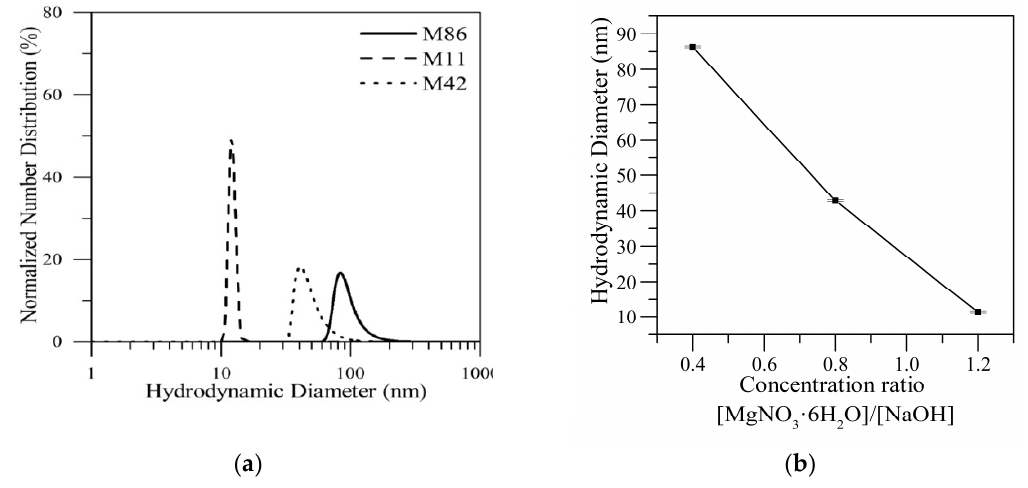
Figure 4. ( a ) Normalized number distribution of three different sizes of MgO nanoparticles 11 (M11), 42 (M42), and 86 nm (M86) based on DLS measurements at 25 °C, where the number of the nomenclature refers to the hydrodynamic diameter (nm) found for each particle, and ( b ) the size of MgO nanoparticles related to the variation of the concentration ratio of the precursor.